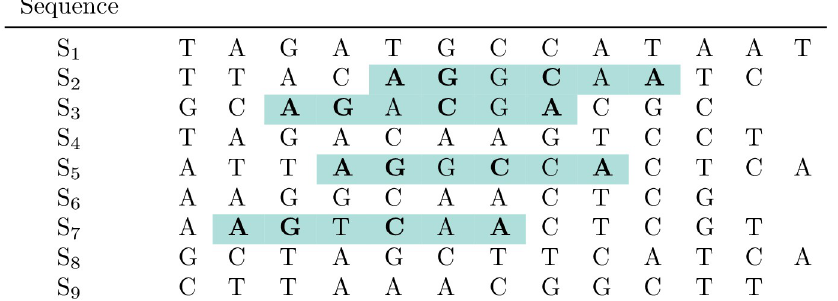
Fig 2. Quartet block with respect to the binary pattern 110101 representing match positions (‘1’) and don’t-care positions (‘0’). The shown quartet block involves sequences S 2 , S 3 , S 5 , S 7 ; the spaced word ‘ A G � C � A ’ occurs in all four sequences. A quartet block can be seen as a local, gap-free four-way alignment with matching residues at the match positions and possible mismatches at the don’t-care positions of the underlying binary pattern. Note that this is a toy example, in practice we are using binary patterns of length 110 with 10 match and 100 don’t-care positions.